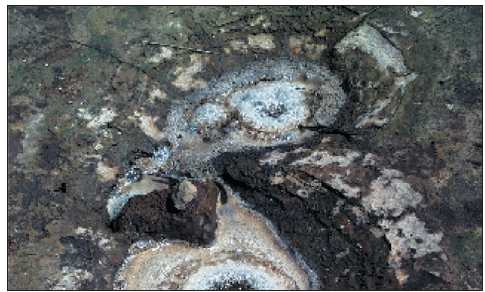
Fig. 2. Mofettes in